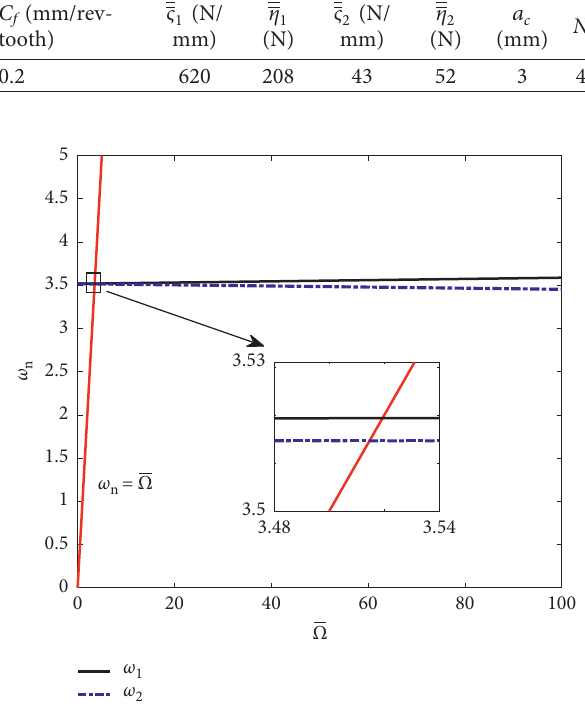
Figure 2: Natural frequency versus rotational speed (L/d � 10, θ � 0 ° ).